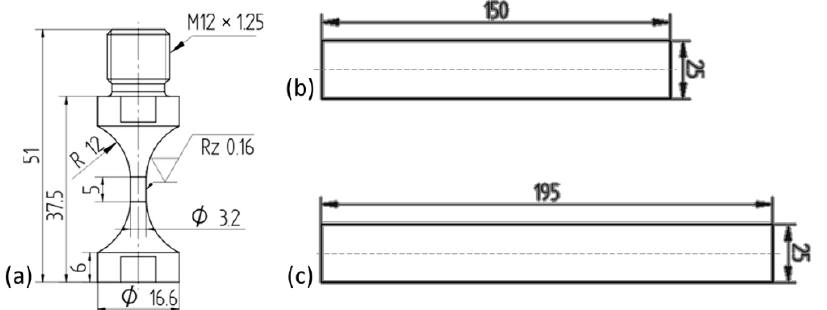
Figure 2. Geometries of ( a ) the VHCF-specimen AISI 347 and the rods ( b ) Z-M4 and ( c ) WFN. (Unit: mm)